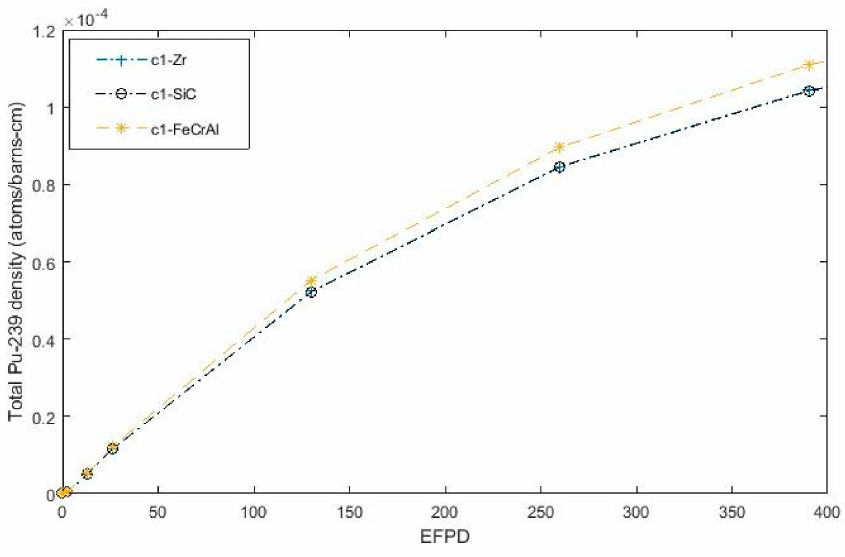
Figure 12. Pu − 239 inventory for different types of fuel − cladding system. C1 − zircaloy, C1 − SiC, and C1 −